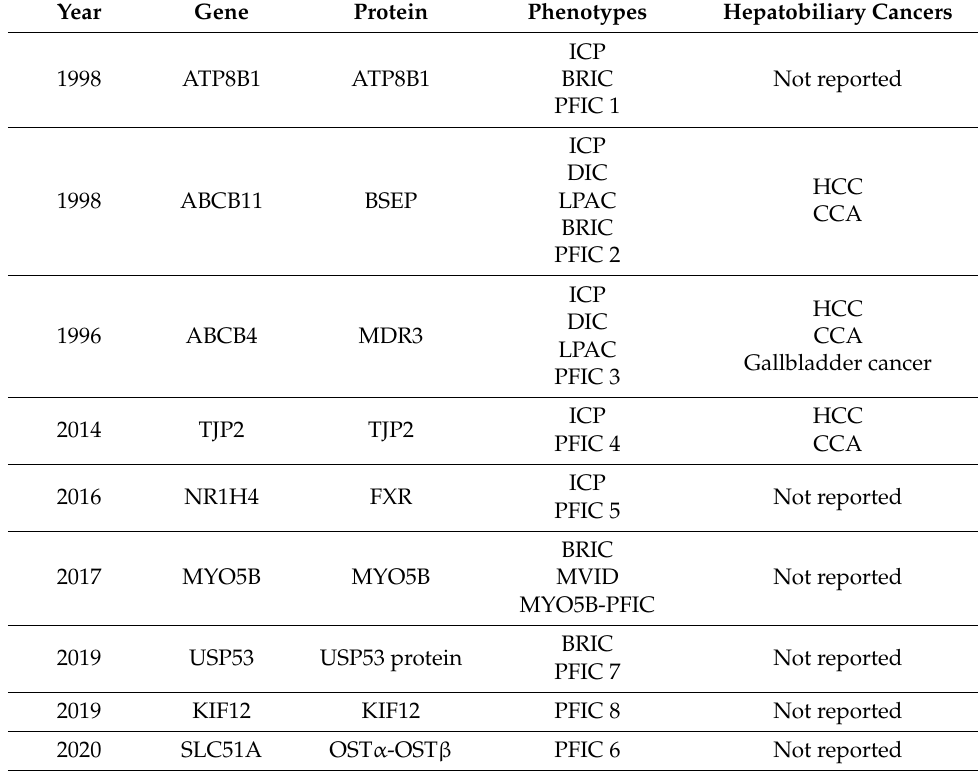
Table 1. List of genes associated with progressive familial intrahepatic cholestasis and their related